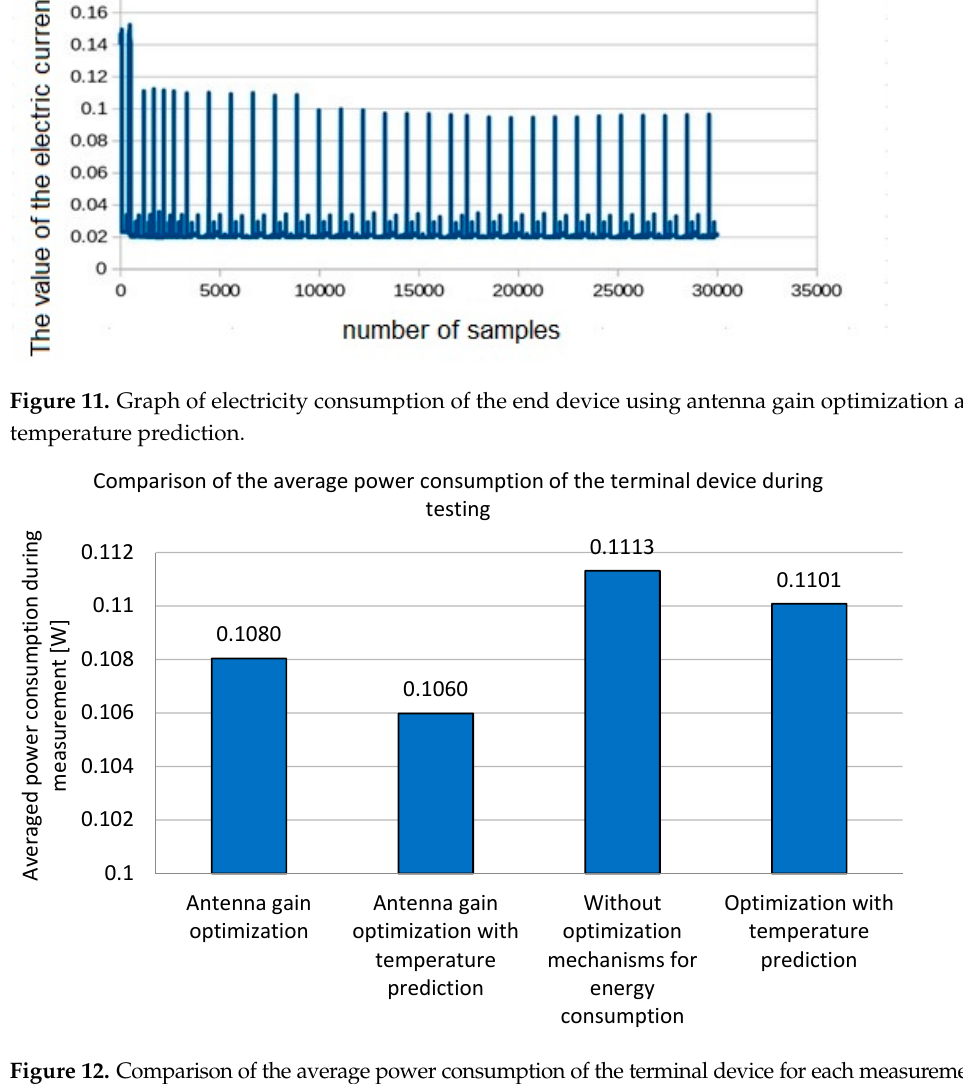
Figure 10. Graph of electricity consumption of the end device using antenna gain optimization. The last measurement was carried out with a temperature prediction and antenna gain optimization implemented. The result was a halving of the frequency at which the radio network sends data and reduces current consumption due to the reduction in gain. The test results are shown in Figure 11.